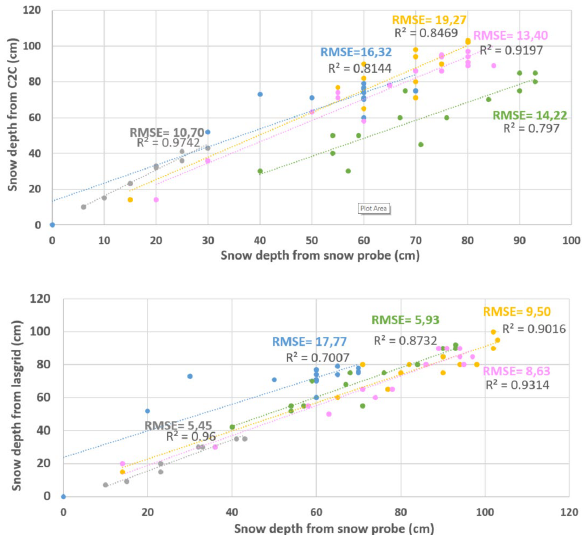
Figure 6 . Linear correlations and RMSE for snow depths derived from C2C and DoD lasgrid algorithm. The different colors correspond to the five different transects.